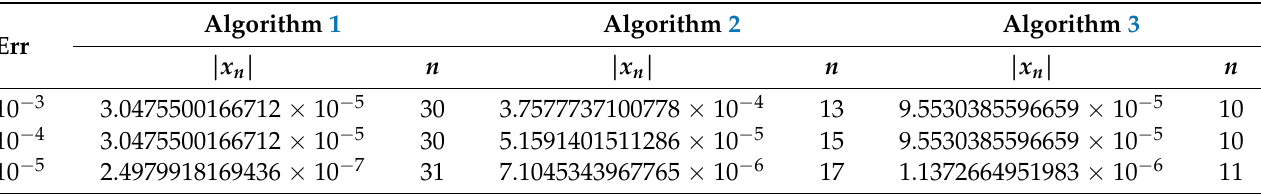
Table 4. Numerical results for Example 4 in Case